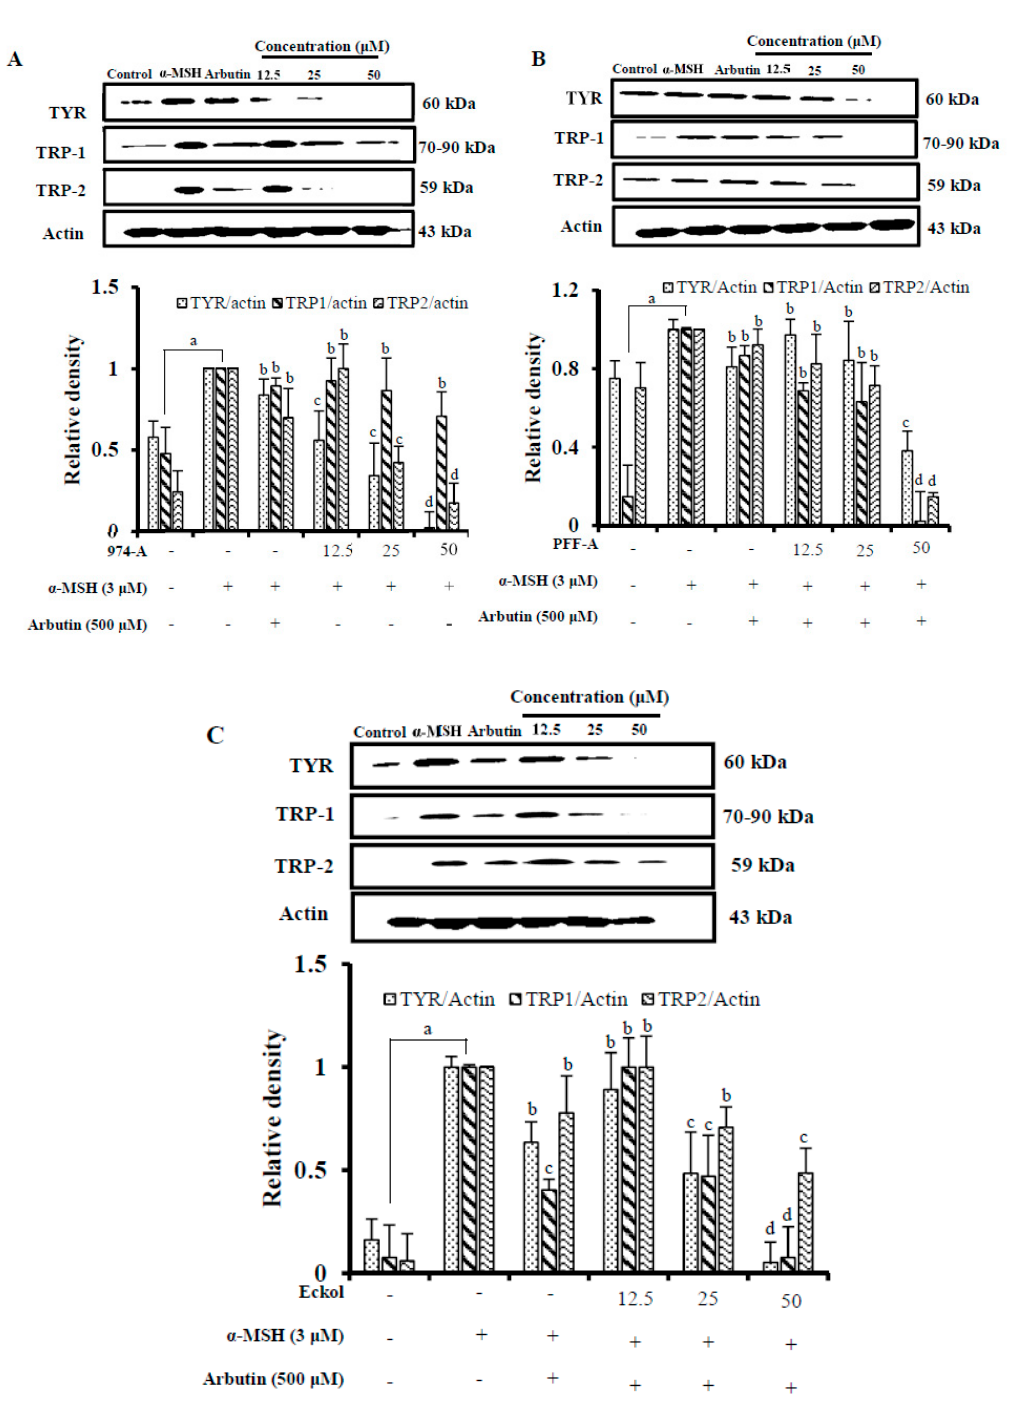
Figure 4. E ff ect of di ff erent concentrations of 974-A ( A ), phlorofucofuroeckol-A (PFF-A) ( B ), and eckol ( C ) on tyrosinase (TYR), tyrosinase related protein-1 (TRP-1), and TRP-2 expression level in α -MSH. Cells were pretreated with the indicated concentration of 974-A, phlorofucofuroeckol-A (PFF-A), eckol along with α -MSH and arbutin for 24 h. Western blotting was performed and protein band intensities were quantified by densitometric analysis using CS analyzer Eng software. Upper panels display representative blots. Equal protein loading was ensured and normalized against β -actin levels. Data represent the mean ± SD of three independent experiments. a p < 0.01 indicates significant di ff erences from the normal control group (no treatment); b p < 0.05, c p < 0.01, and d p < 0.001 indicate significant di ff erences from the α -MSH treated group.